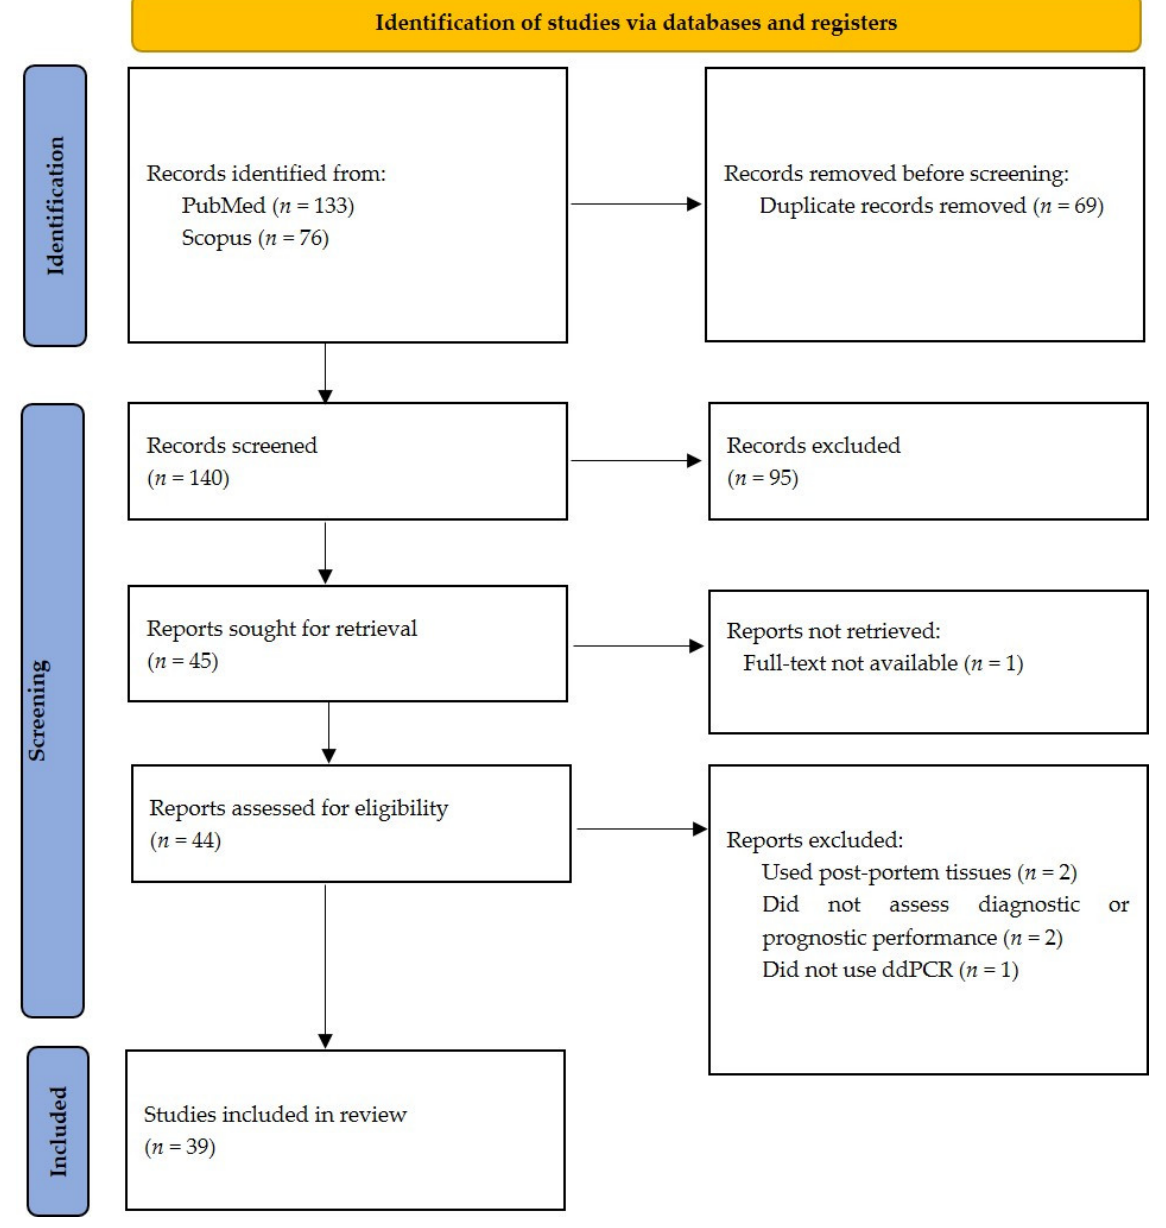
Figure 1. PRISMA flowchart for study screening and selection.